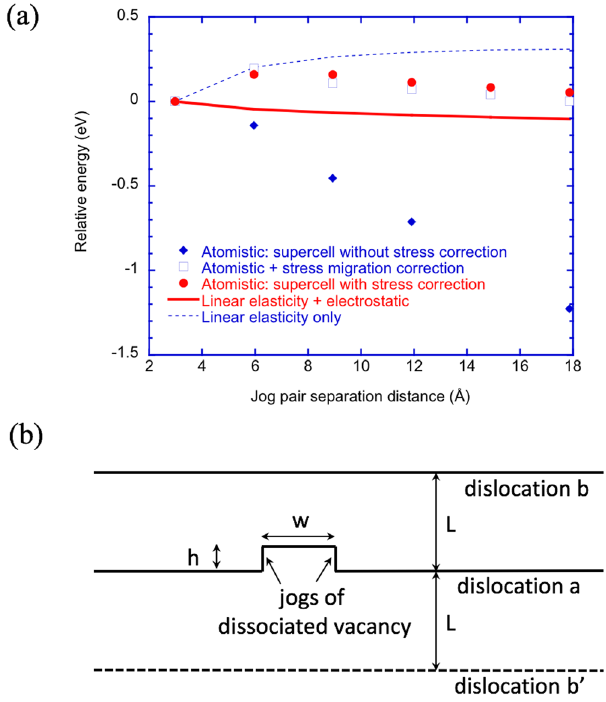
Figure 2. ( a ) The calculated atomistic energies of the dissociated vacancy as a function of separation of the two jogs in MgO (blue filled diamond symbols - supercell without stress correction; red filled sphere symbols - supercell with stress correction; blue square symbols - the case of supercell without stress correction plus stress migration energies). The continuous line corresponds to a model with electrostatics (charged jogs) while the dotted-line corresponds to model results without electrostatic contributions (neutral jogs). ( b ) Schematic of the dislocation model used to calculate the energetics of the dissociated vacancy as a function of jog-jog separation w